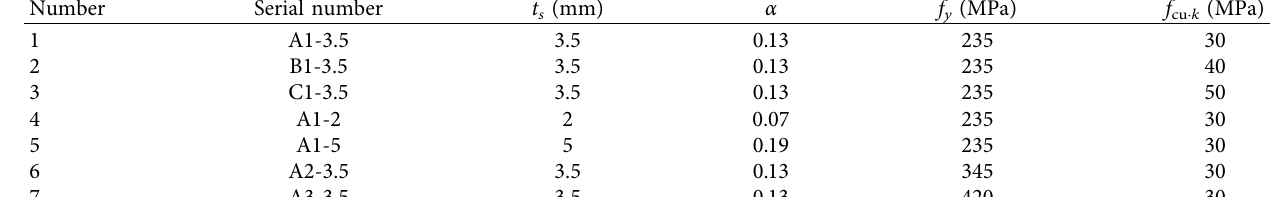
Table 7: Simulation test piece parameters.